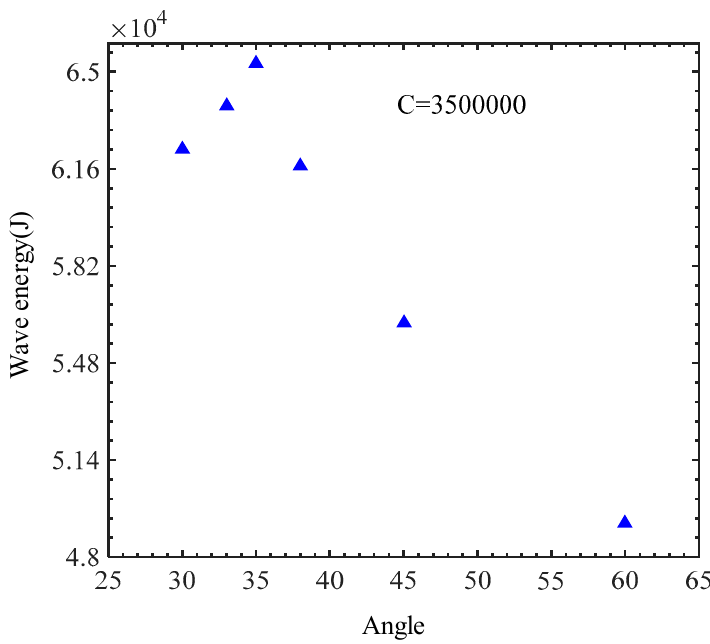
Figure 4. Captured wave energy with different slope angles.